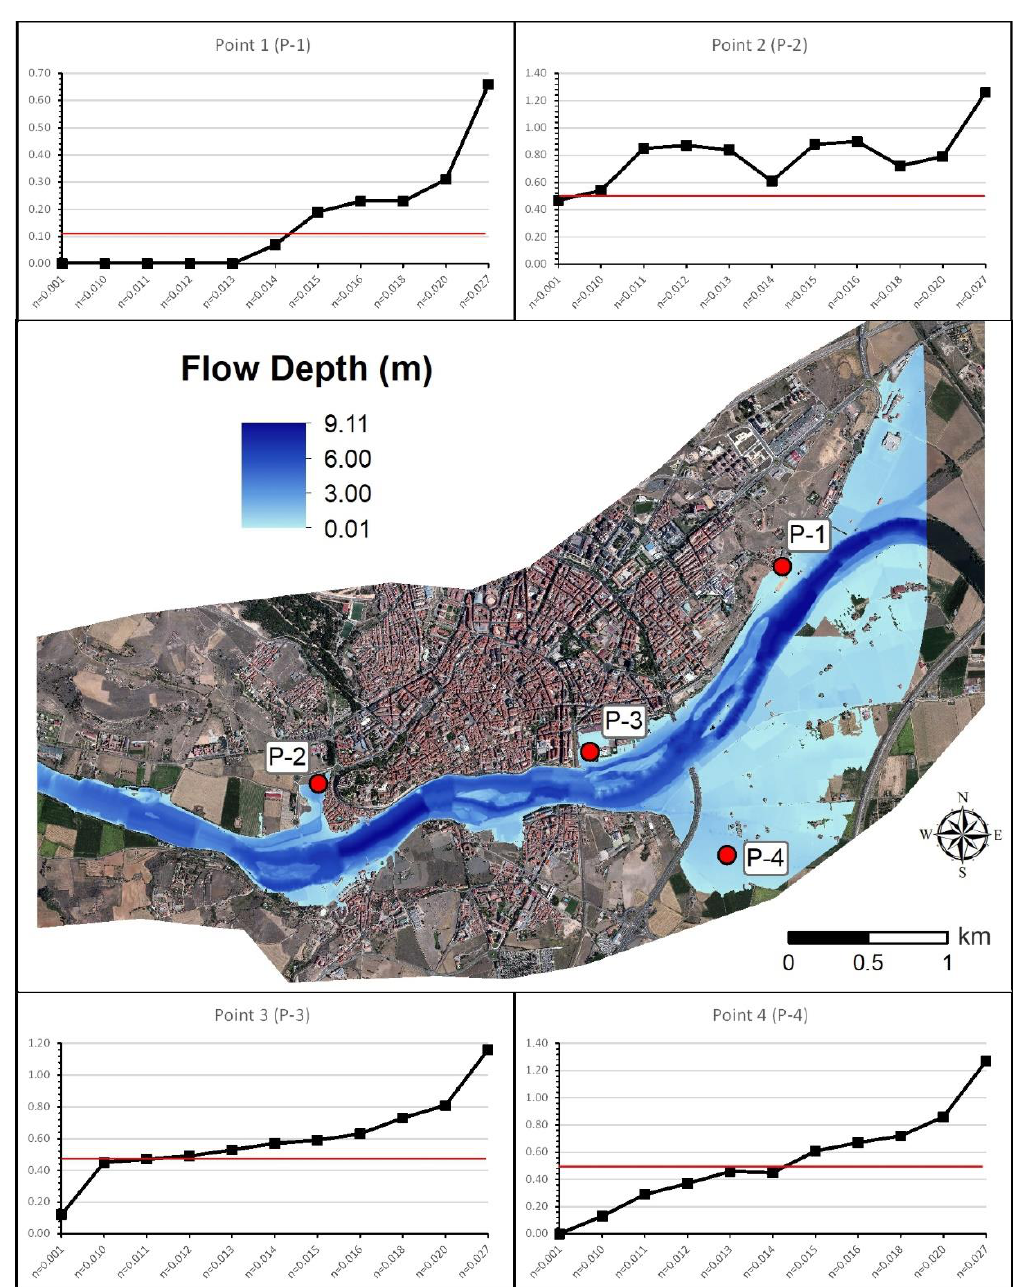
Figure 8. Local Manning’s n value calibration results at control points in Zamora city. The upper and lower graphs show flow depth values for each calibrated model, where the red line shows the flow depth value for the control model, i.e., the “real s cenario”.